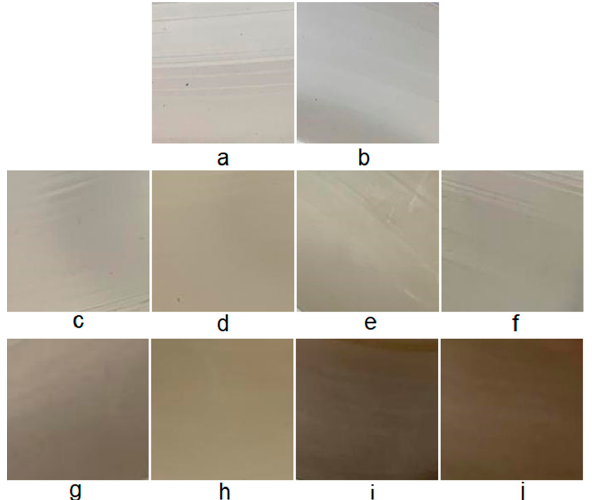
Figure 1. External appearance of the obtained polymeric materials, containing 0%, 0.5%, 1.0%, 2.0% and 5.0% of birch bark extract (BBE) and received with the use of ultrasonic treatment (with US) and without the use of ultrasonic treatment (without US): ( a ) 0% BBE without US; ( b ) 0% BBE with US; ( c ) 0.5% BBE without US; ( d ) 0.5% BBE with US; ( e ) 1.0% BBE without US; ( f ) 1.0% BBE with US; ( g ) 2.0% BBE without US; ( h ) 2.0% BBE with US; ( i ) 5.0% BBE without US; ( j ) 5.0% BBE with